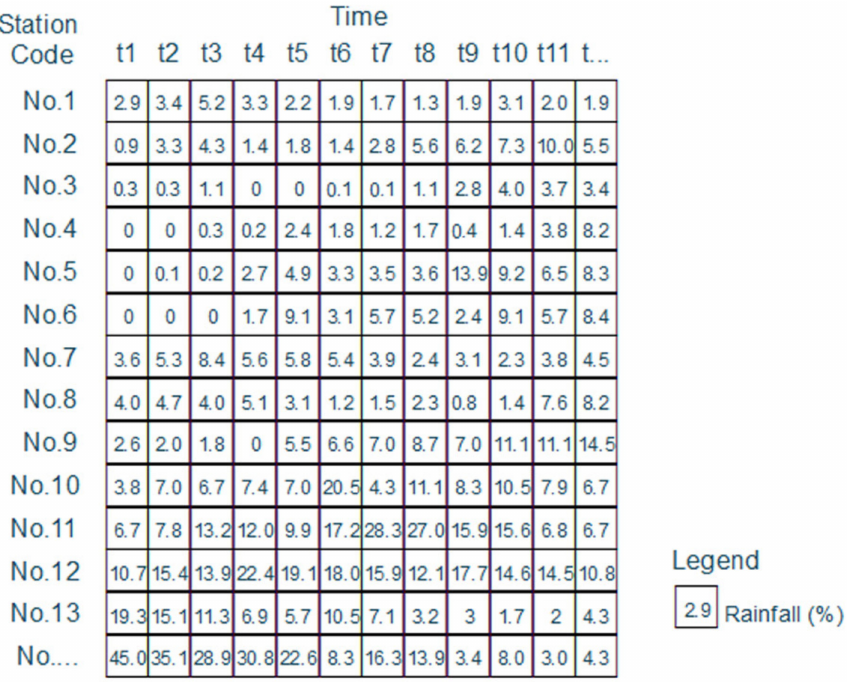
Figure 4. Sample of rainstorm